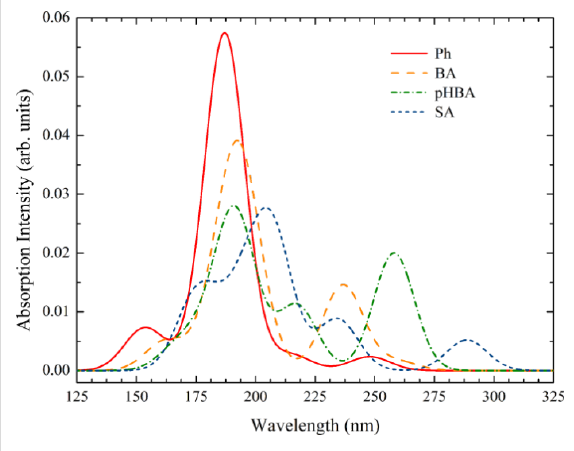
Figure 3: Simulated UV–vis absorption spectra of the first 10 transi- tions for neutral pollutants in water, calculated by TD-DFT. The spec- tral lines were convoluted with Gaussian distributions of 20 nm linewidth at half maximum.